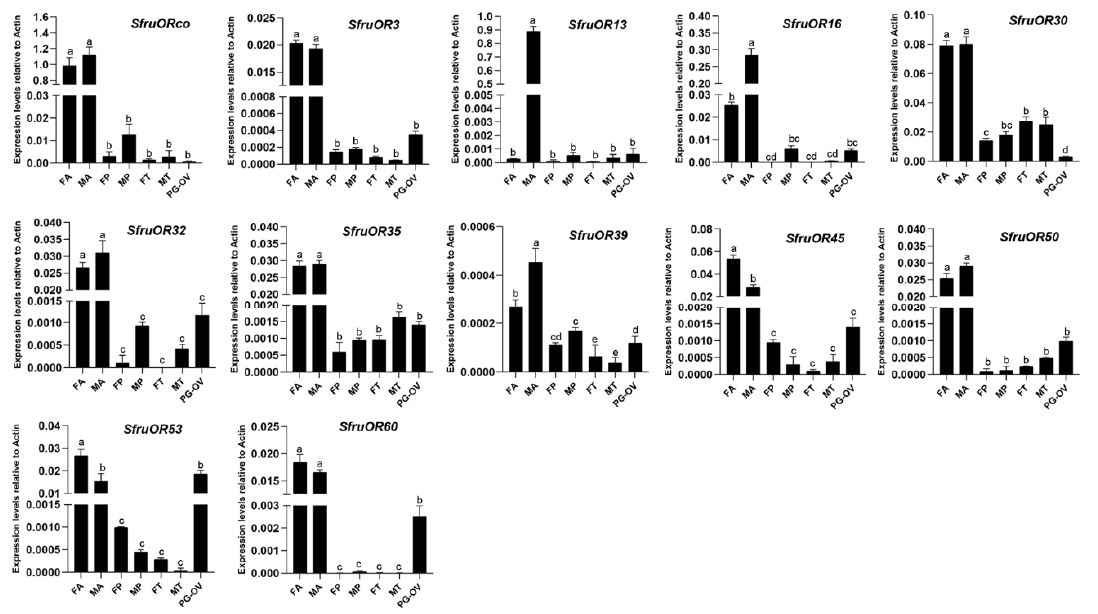
Figure 3. Expression patterns of candidate ORs in different tissues of S. frugiperda . RT-qPCR analysis of candidate OR genes was carried out in female antennae (FA), male antennae (MA), female pro- boscises (FP), male proboscises (MP), female tarsi (FT), male tarsi (MT), and the female pheromone gland-ovipositor (PG-OV). Values are means + SE; in each panel, means with different letters are significantly different according to a one-way ANOVA followed by Tukey’s multiple comparison test ( p < 0.05, n = 3).